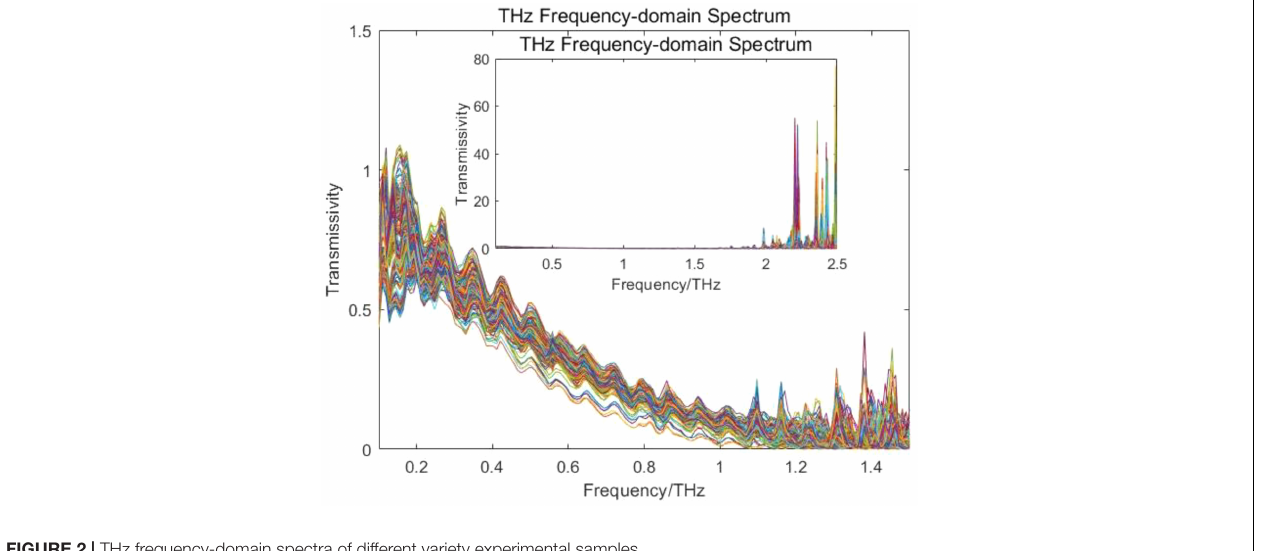
FIGURE 2 | THz frequency-domain spectra of different variety experimental samples.